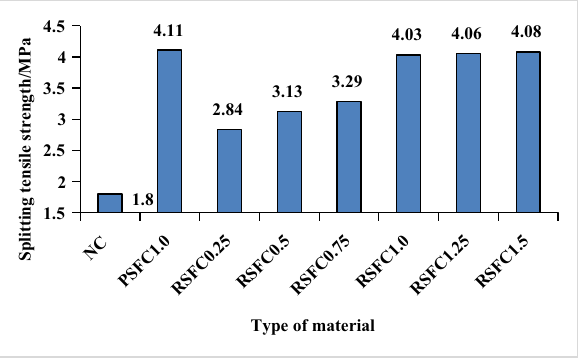
Figure 12: Splitting tensile strength